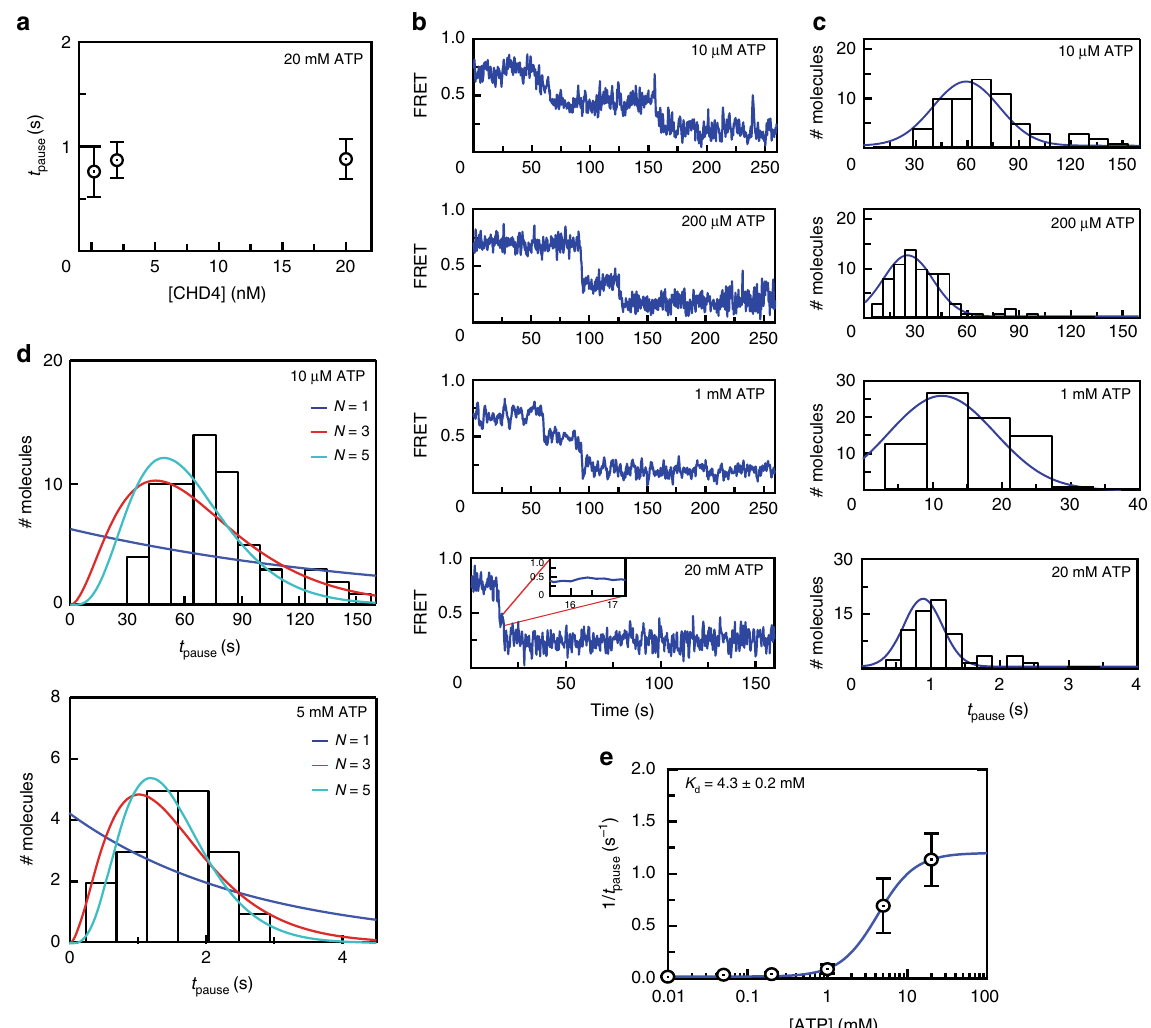
Fig. 4 CHD4-mediated nucleosome sliding is processive and depends on the binding of multiple ATP molecules. a Distribution of t pause times for remodelling of 0 AF555 w60 Bio at the indicated CHD4 concentrations and 20 mM ATP. Error bars represent standard deviation (of 45, 74 and 56 independent single particles at 0.2, 2 and 20 nM CHD4, respectively). b Typical traces from smFRET assays carried out with 2 nM CHD4 and at the indicated ATP concentrations. c Histograms showing t pause distributions of 70 – 82 particles from the experiments shown in ( b ). The histograms are fi tted to a Gaussian distribution. d Pause time histograms for experiments carried out at 10 μ M ATP (top) or 5 mM ATP (bottom) are overlaid with gamma distributions depicting different numbers of fundamental reaction steps ( N = 1 – 5). e A 1:1 binding isotherm fi t of the mean t pause time as a function of ATP concentration, with data taken from the assays in ( c ). Error bars represent standard